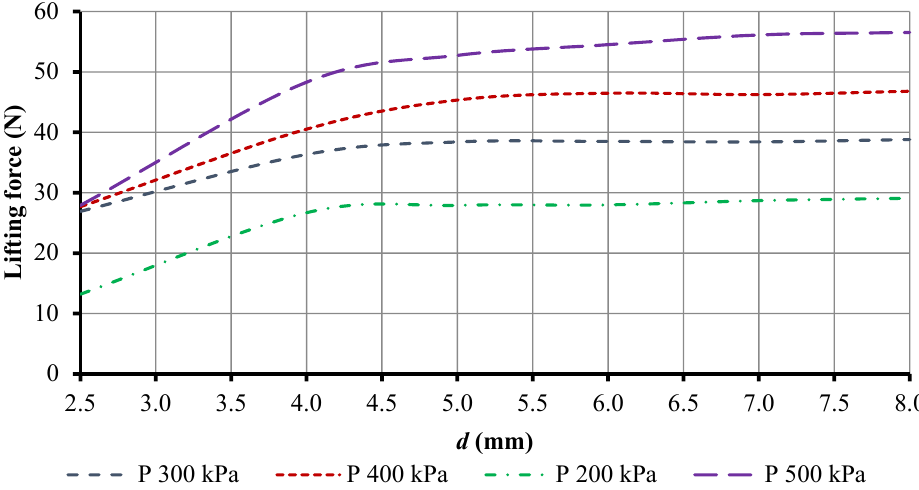
Figure 12. Influence of fitting constriction diameter on a BGD’s lifting force at different pressures.